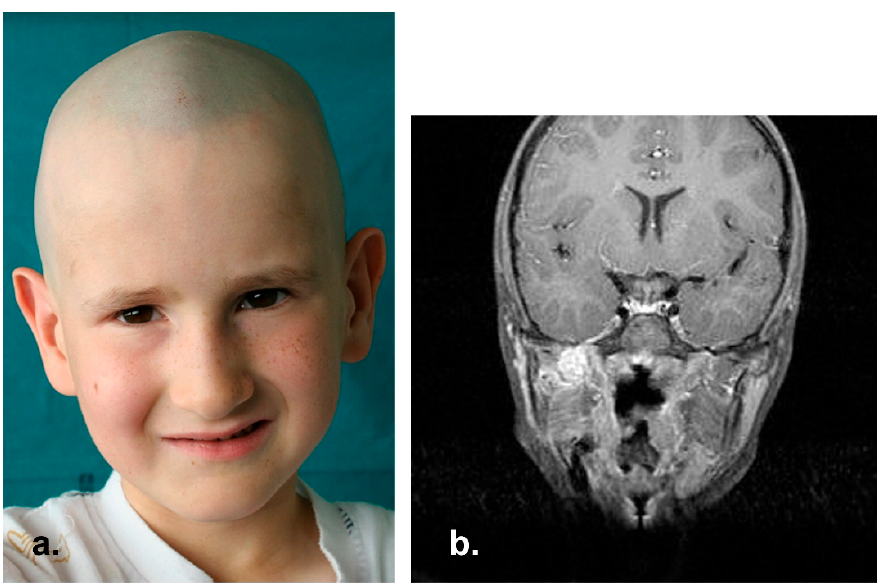
Figure 8. Rhabdomyosarcoma relapse in right masticatory space. ( a ) Clinical picture. ( b ) MRI coronal view showing an enhanced mass in the right pterygopalatine fossa after contrast administration.